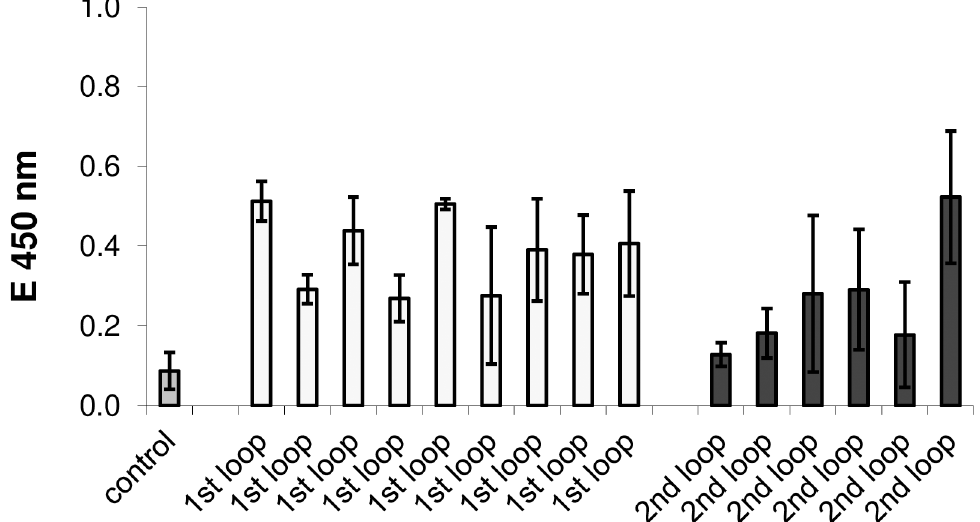
Fig 3. Direct ELISA for beta1-AAB detection in human IgG preparation. Direct ELISA testing bioassay characterized patient sera (DCM containing autoantibodies specific for the 2 nd extracellular loop of the beta1-adrenoceptor, “2 nd loop”, black columns) versus 1 st loop specific control sera (“1 st loop”, light grey columns) and an autoantibody free sample (dark grey column). 10 μ l IgG precipitates of the sera were applied onto plates coated with 1 μ g/well immunogen-peptide. Bars show the mean ± SD of three independent tests. Anti-human IgG-POD (1:10,000) /TMB served for detection and quantification. Data are presented as the mean of three independent assays.